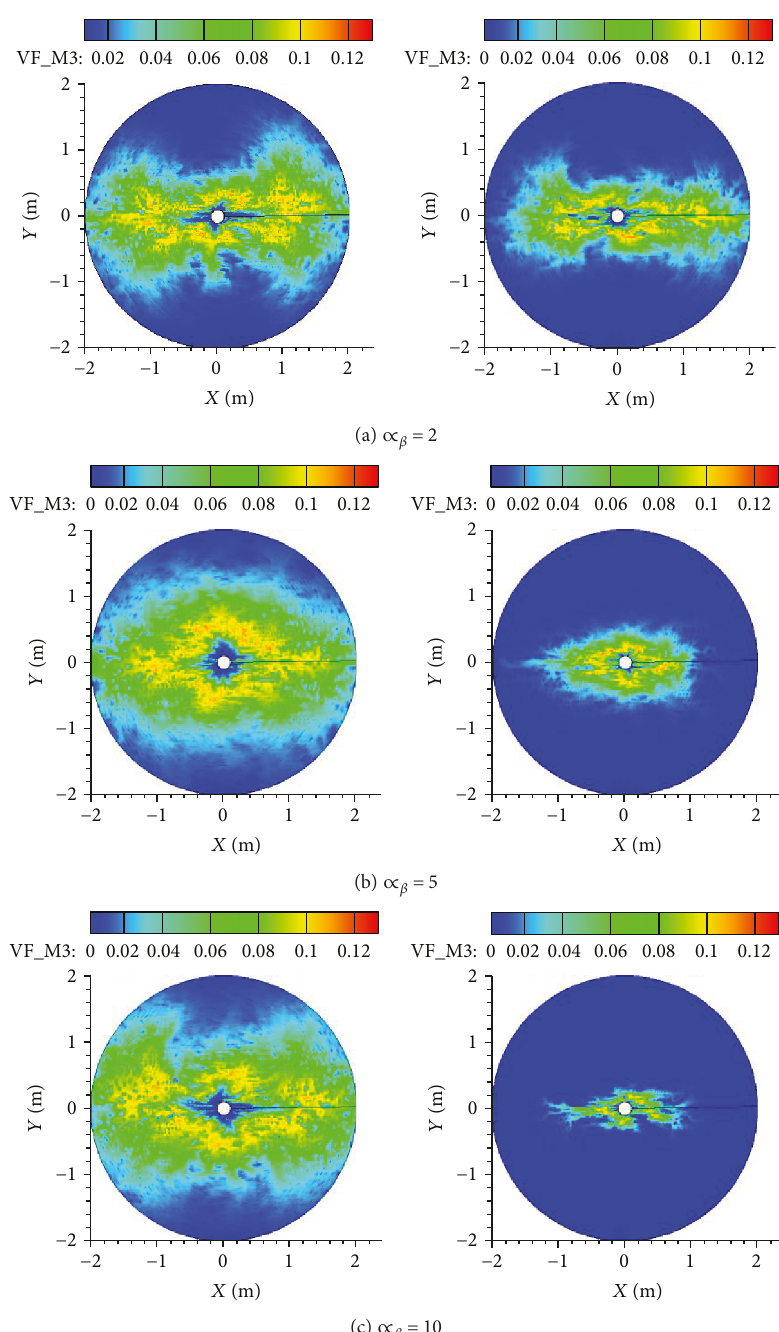
Figure 13: Silica precipitation distribution in two 5.5. E ff ect of Areal Heterogeneity. Areal heterogeneity can be